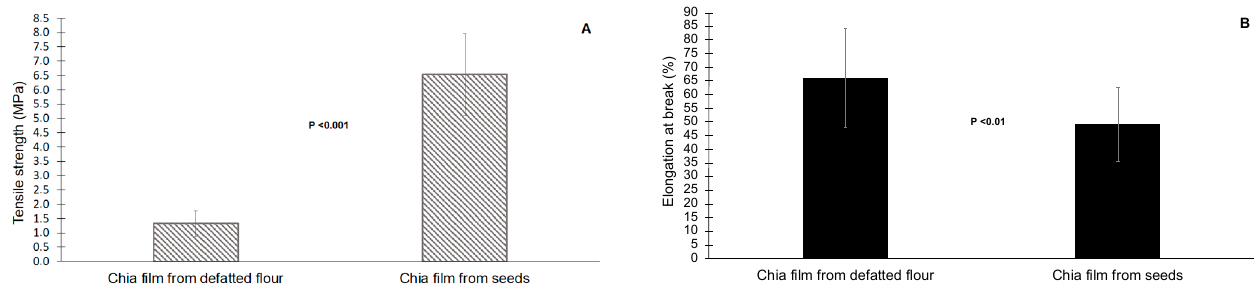
Figure 2. Tensile strength ( A ) and elongation at break ( B ) of the chia films made with whole seeds and defatted flour.